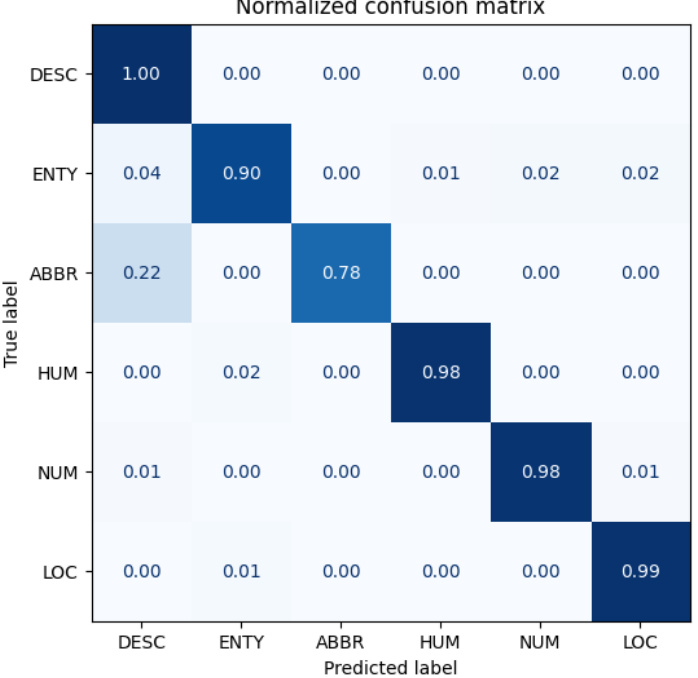
Figure 15. Original Model Confusion Matrix on TREC.